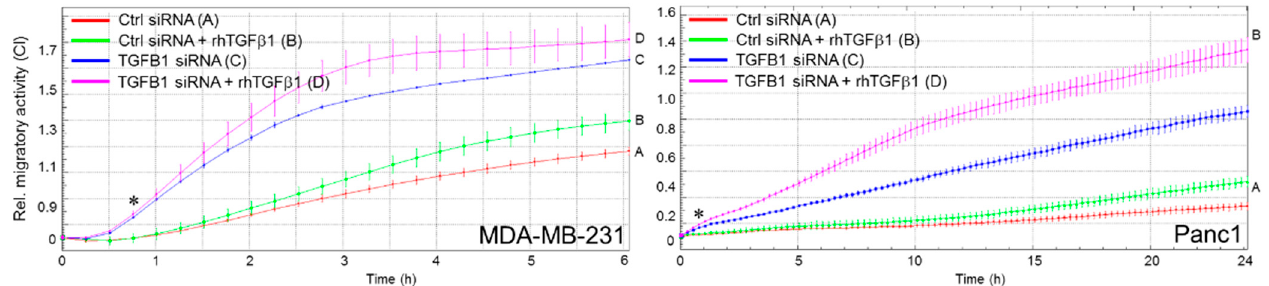
Figure 2. Effect of knockdown of endogenous TGFB1 on basal and rhTGF β 1-dependent migration in triple-negative breast cancer (TNBC) and pancreatic ductal adenocarcinoma (PDAC)-derived tumor cells. MDA-MB-231 (left-hand graph) or Panc1 (right-hand graph) cells were transiently transfected with 50 nM of either a scrambled control (Ctrl) siRNA or TGFB1 siRNA and 48 h later subjected to impedance-based real-time measurement of random cell migration in the presence of rhTGF β 1 (5 ng/mL) for 24 h. Data represent the mean ± SD of 3–4 parallel wells for each condition. Differences between the green curves (tracing B) and the magenta curves (tracing D) were first significant at the 0:45 h time point ( ∗ ) and remained so during the entire observation period. Statistical significance was determined with the unpaired two-tailed Student’s t -test from the raw data of the various curves. Successful knockdown of TGFB1 was verified by ELISA of secreted TGF β 1 in culture supernatants.